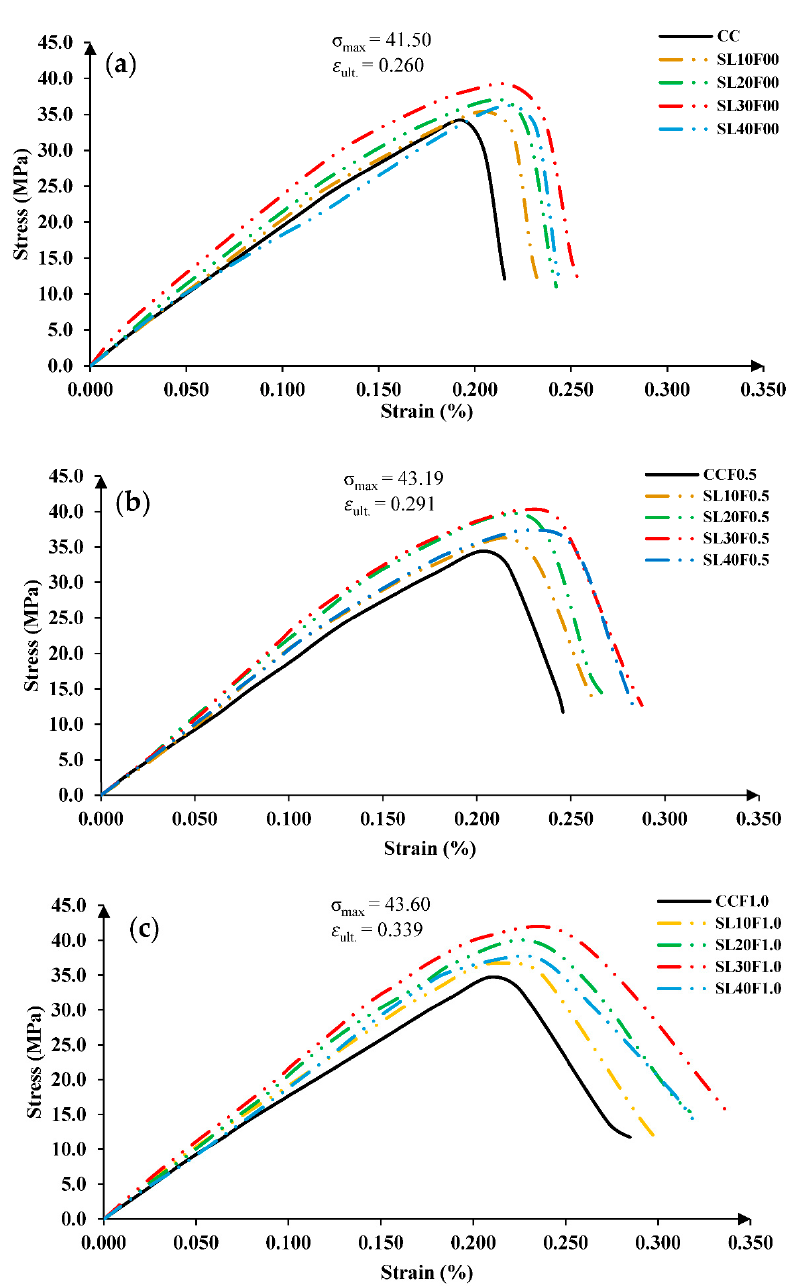
Figure 6. Axial stress–strain curves of all concrete groups ( a ) Slag + 0.0% PP fibers group. ( b ) Slag + 0.5% PP fibers group. ( c ) Slag + 1.0% PP fibers group.